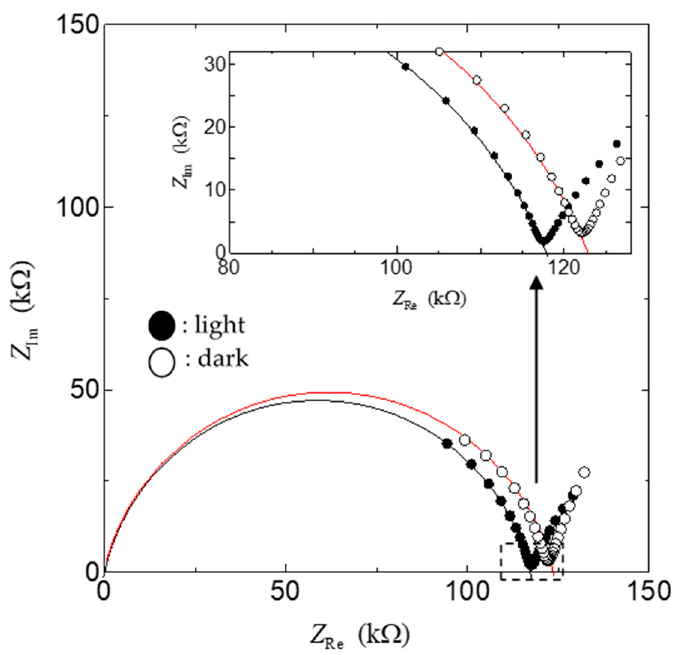
Figure 7. Example of Nyquist plot in the PSII–chitin composite film in the dark (open circle) and under the light irradiation (solid circle). Inset is the enlarged spectra near Z re = 120 k Ω .